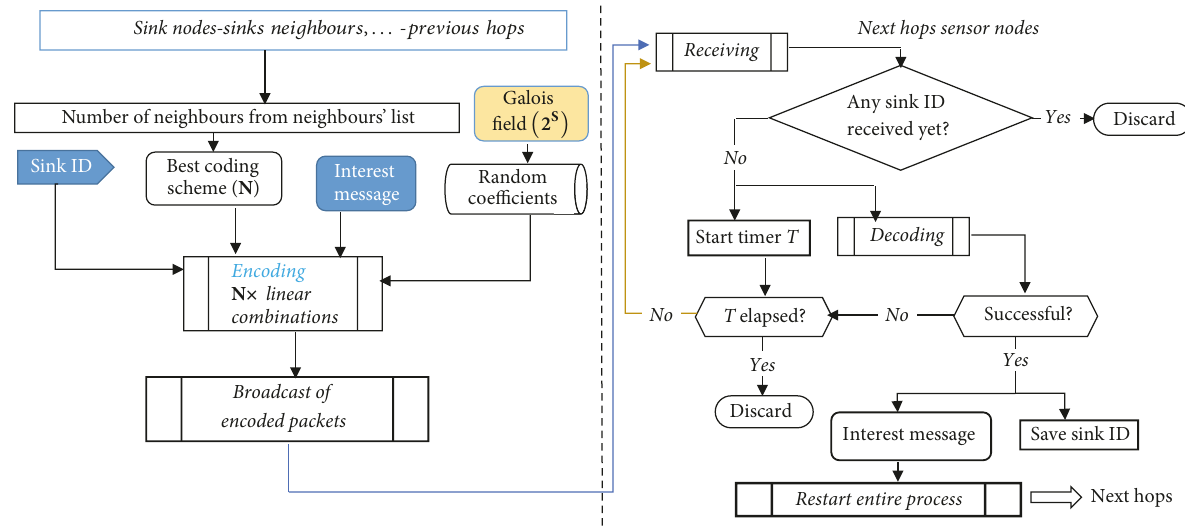
Figure 3: CoAdNC-GBR algorithm